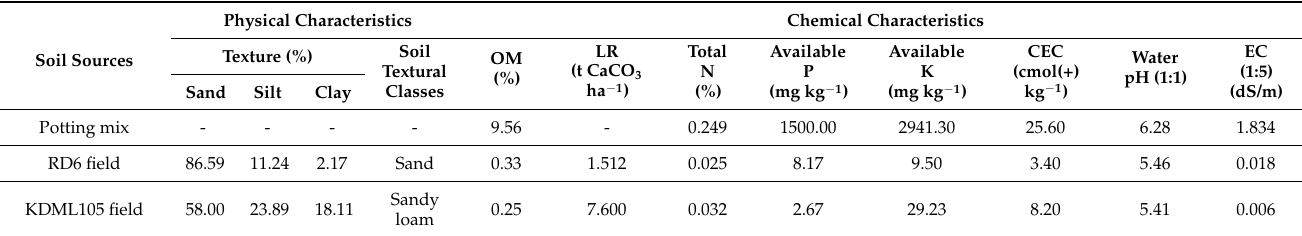
Table 1. Physical and chemical characterization of the soil collected from three different